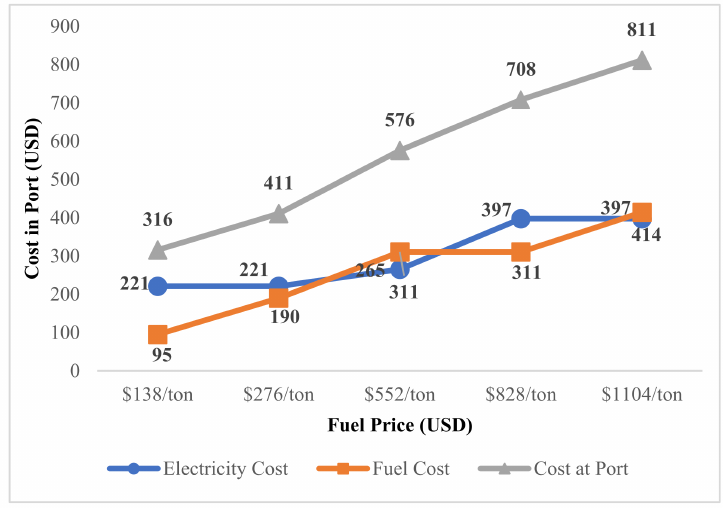
Figure 4. Cost analysis under different fuel types without considering pollution gas emission.